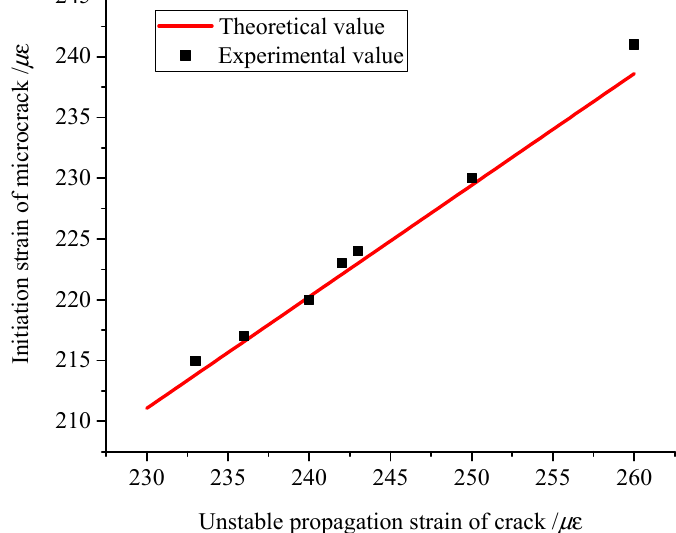
Figure 14. The relationship between crack initiation strain and unstable propagation strain.